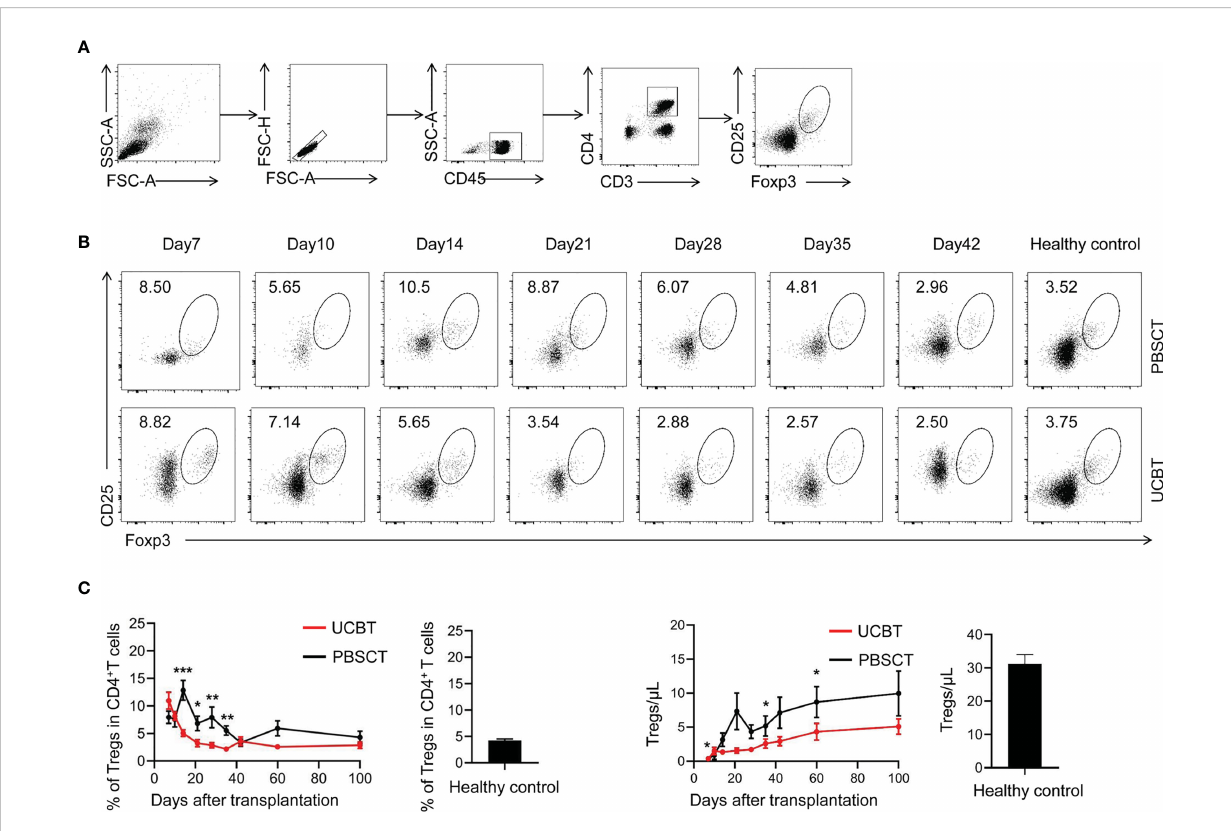
FIGURE 3 The UCBT group show a lower percentage and numbers of CD25 + CD4 + FOXP3 + Tregs compared to the PBSCT group. (A) Representative fl ow cytometry dot plots and the frequencies of CD25 + CD4 + FOXP3 + Tregs on days 7, 10, 14, 21, 28, 35, and 42 after UCBT and PBSCT. (B) The frequencies and the numbers of CD25 + CD4 + FOXP3 + Tregs within 100 days after UCBT and PBSCT. The data was analyzed using the Mann – Whitney U test and represented as means ± SEM. * p <0.05; ** p <0.01; *** p